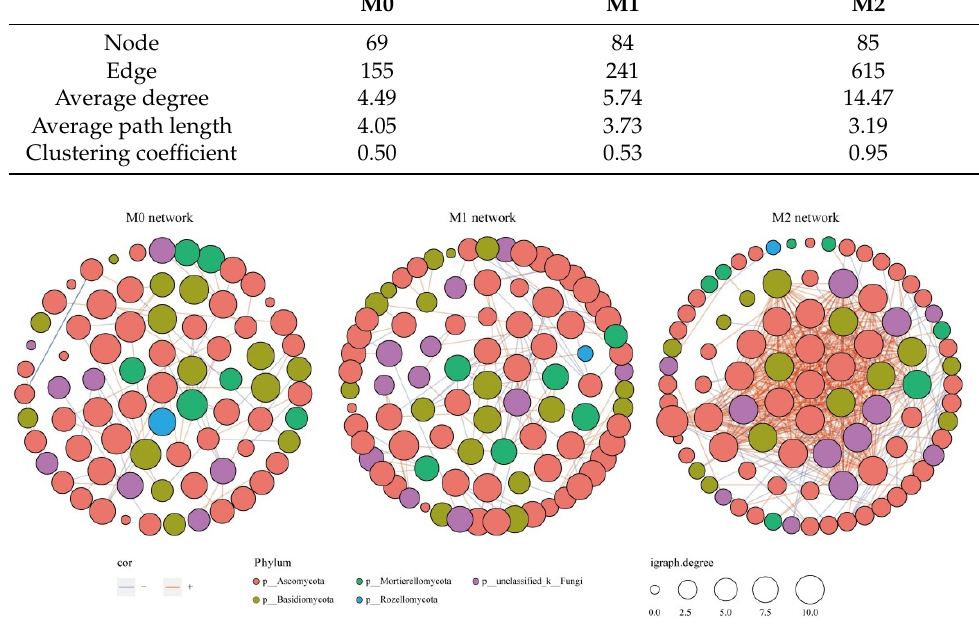
Figure 4. Co-occurrence networks of fungi in the bamboo soils from three management practices, based on Spearman’s correlation analysis between OTUs. Red (+) and blue ( − ) lines denote significant ( ρ > |0.6|, p < 0.05) positive and negative correlations, respectively. The size of each node represents the connection number (degree). Nodes are colored by phylum. Table 3. Fungal network properties at different plantation management practices.